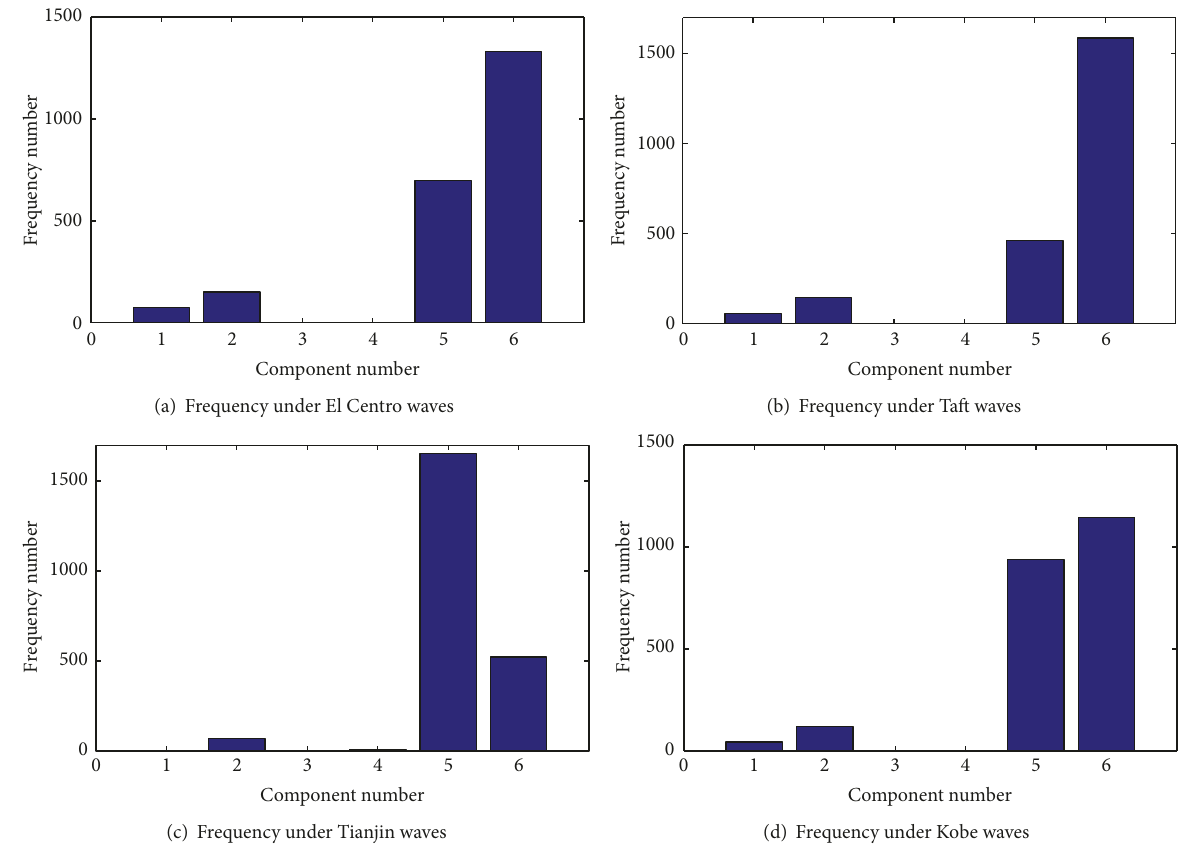
Figure 13: Frequency of importance coefficient of 6 types of